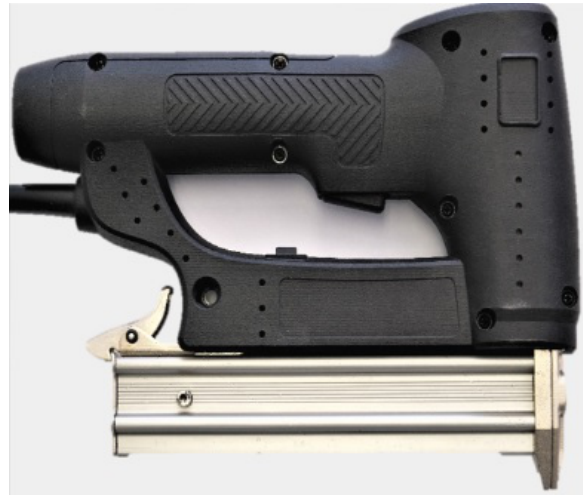
Fig. 16. The nail shooting device.